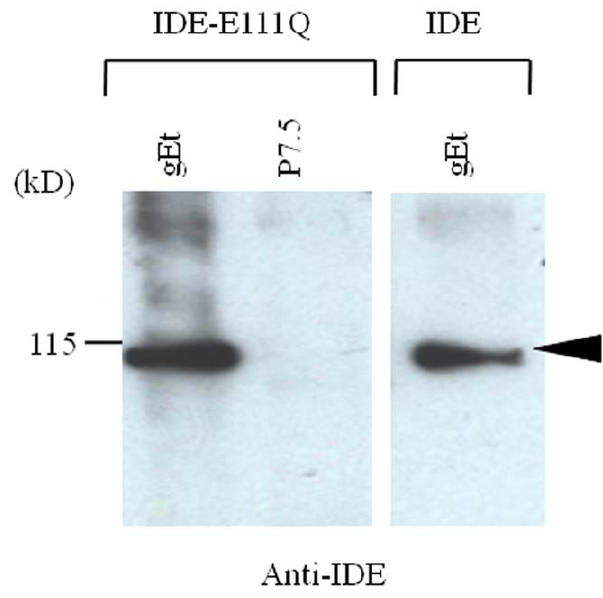
Figure 6. IDE mutant protein, IDE-E111Q binds to gEt. gEt but not control protein p7.5, pulled down both IDE-E111Q protein and wild- type IDE (arrow).